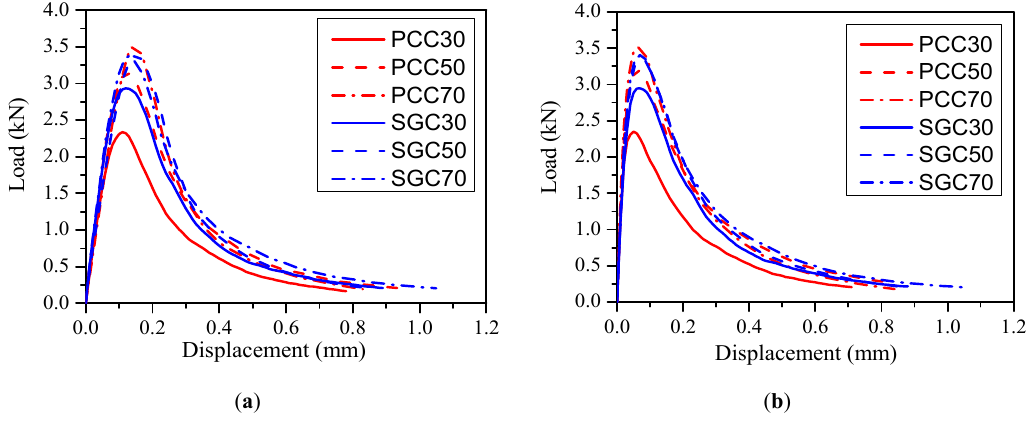
Figure 2. Typical ( a ) load vs. mid-span displacement ( P-d ) and ( b ) load vs. crack mouth opening displacement ( P -CMOD) curves of Portland cement (PC) and slag-based geopolymer (SG) concrete beams. Table 4. Average fracture parameters of the PC and SG concrete and